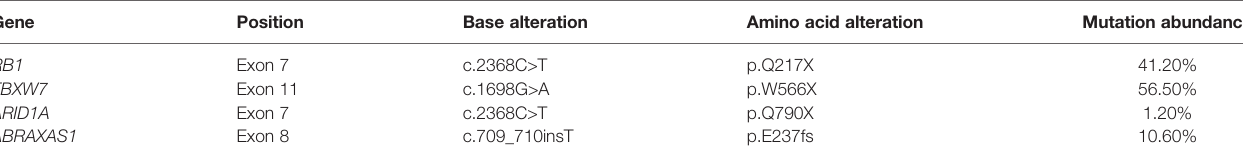
TABLE 1 | Results of gene mutation analysis of the patient tumor tissue.